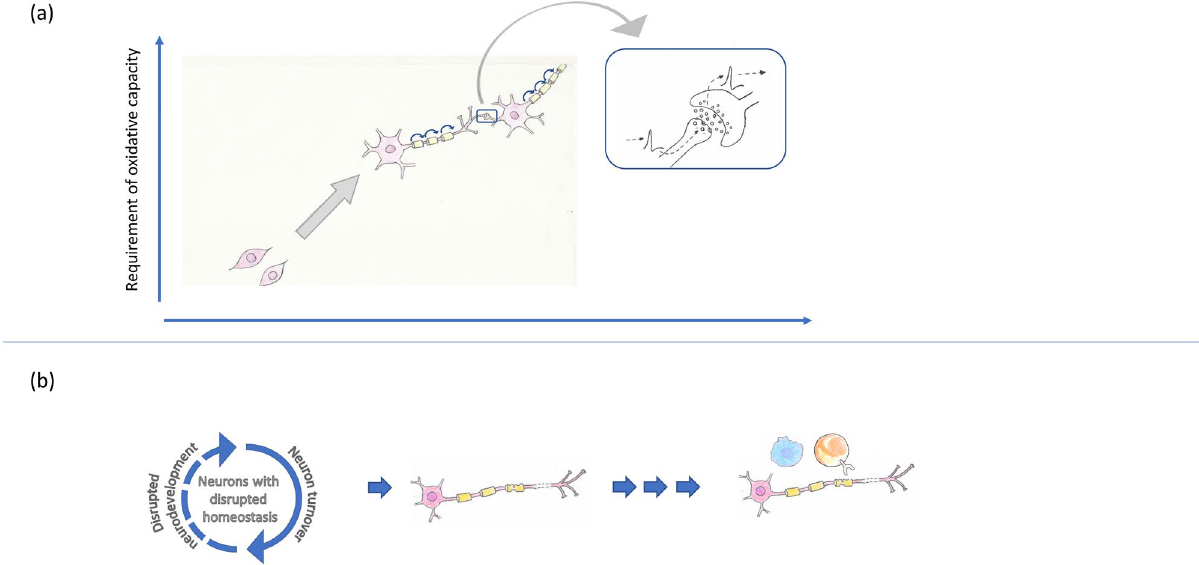
Figure 7. Normal neural development and function require oxidative capacity. ( a ) Requirement for oxidative capacity under normal neural development and homeostasis. ( b ) Loss of oxidative redox potential may be present from the early event in the pathogenesis of MS. We hypothesize that MS is a disease of disrupted neuronal development and homeostasis leading to the typical pathological characteristics of MS, and that inflammation is secondary. The signature of intrathecal inflammation is simplified here by indicating only the immune cells. Artwork performed by Kristiane